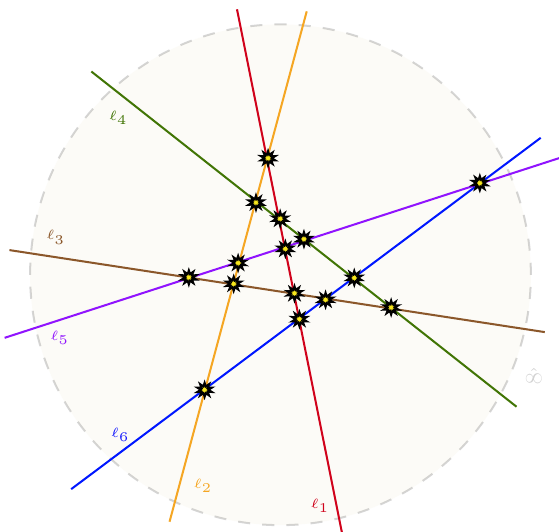
Figure 8 . Six lines (one for each branch point) in general positions on the projective plane. Their ` 15 points P of normal crossing are illustrated by the yellow stars. There are 10 bounded ij “ regions and 12 regions going to infinity. The blown-up moduli space describes a smooth